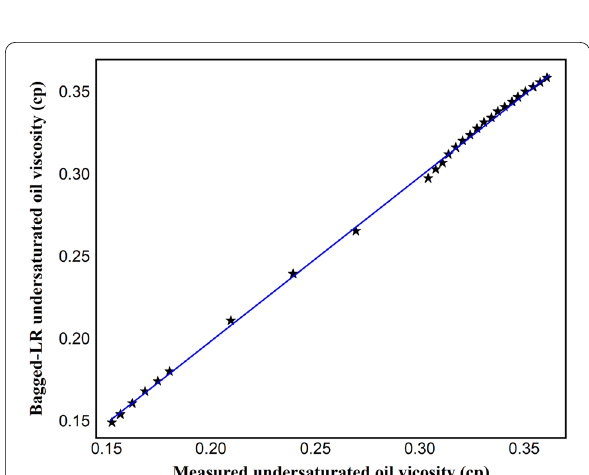
Fig. 13 Cross plot of bagged-LR predicted values versus measured